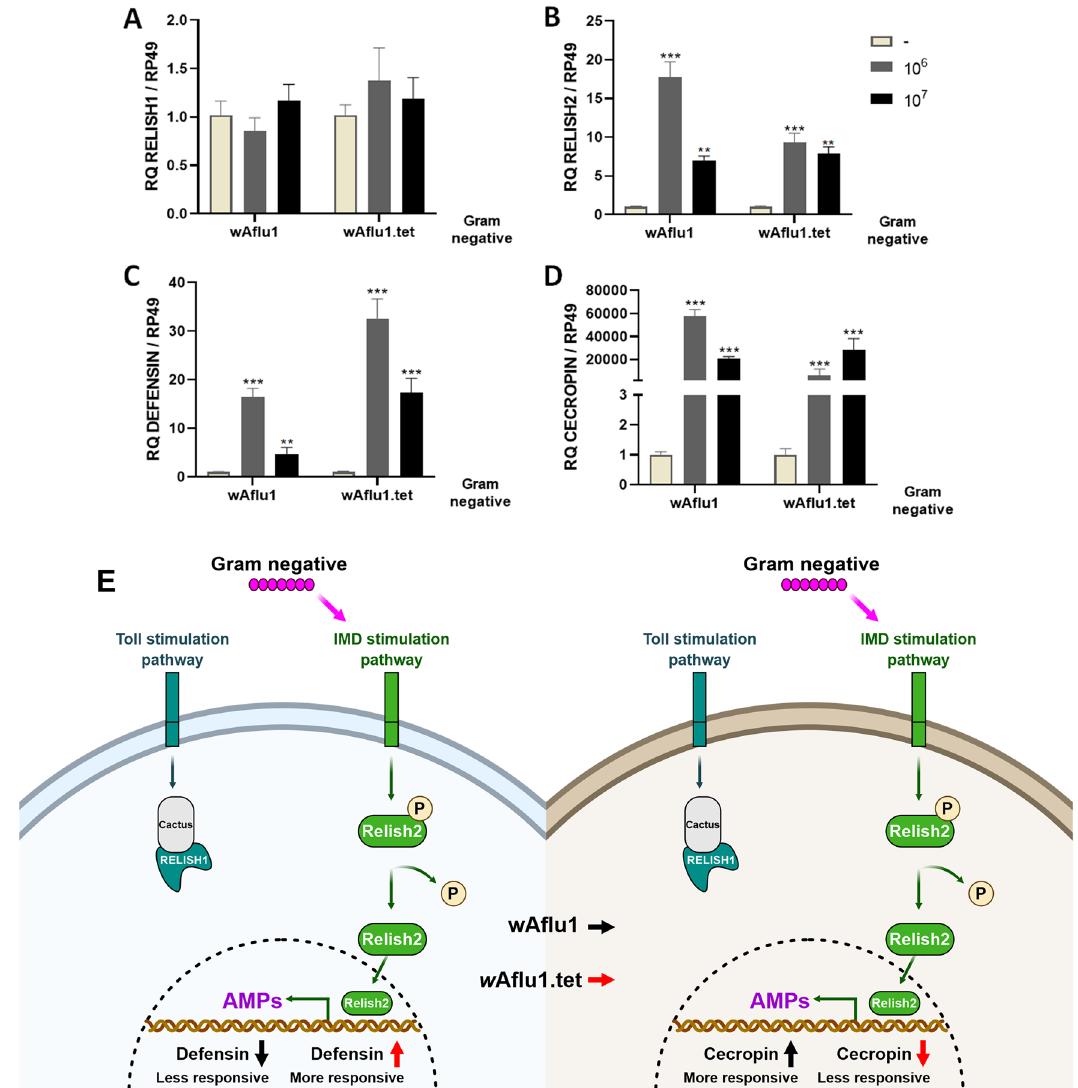
Figure 7. Innate immunity was activated by heat-killed Gram-negative ( Enterobacter cloacae ) bacteria.wAflu1 and wAflu1.tet cell cultures were challenged for 24 h with 10 6 or 10 7 heat-killed Enterobacter cloacae cells, then used for relative mRNA quantification of Relish 1 ( A ), Relish2 ( B ), defensin ( C ) and cecropin ( D ). Schematic representation (Created with BioRender.com) summarizing the different responses of A. fluviatilis cells to heat- killed Gram-negative E. cloacae ( E ). mRNA levels are expressed as mean ± SD (n = 3). Quantitative PCRs were statistically analyzed by ANOVA followed by Dunnett’s multiple comparison test. Asterisks indicate significant differences (**p < 0.01; ***p <